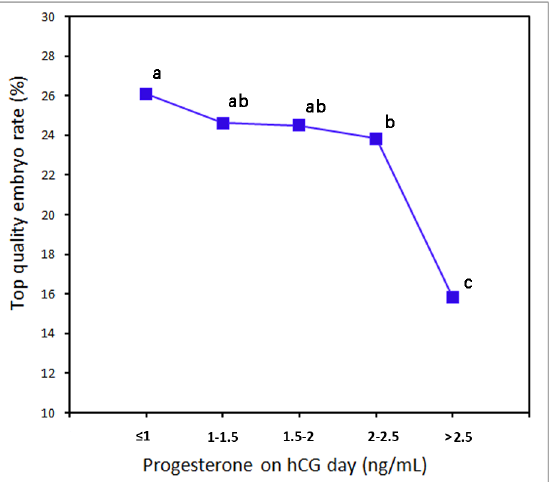
Fig 1. Relationship between serum progesterone concentration and top quality embryo rate. With a decrease in the TQE rate, the serum progesterone concentration increased progressively. When serum progesterone levels were within the interval 2.0 – 2.5 ng/ml and > 2.5 ng/ml, the TQE rate was significantly lower than the progesterone level < 1.0 ng/ml. In each group, values with different superscript letters differ significantly (P <